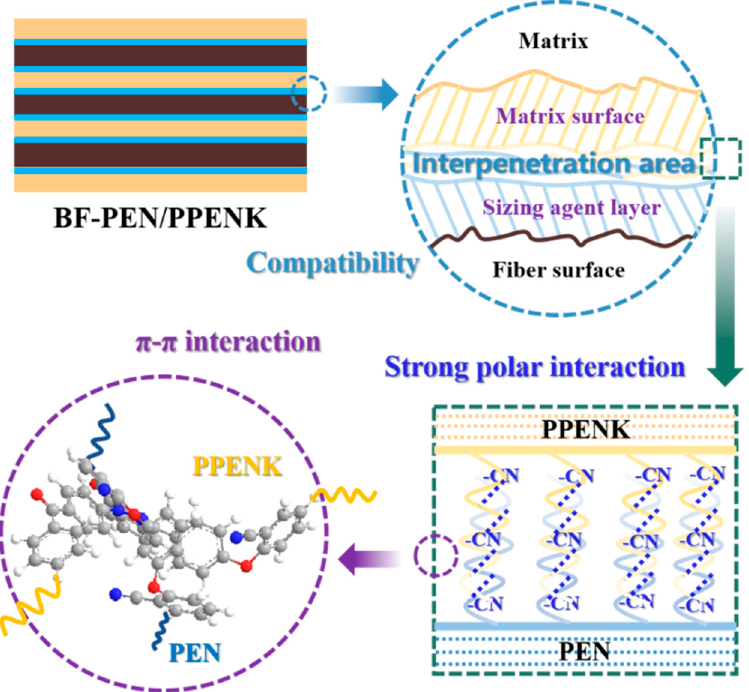
Scheme 2. Schematic diagram of the PEN sizing agent enhancing the BF/PPENK composite interfacial